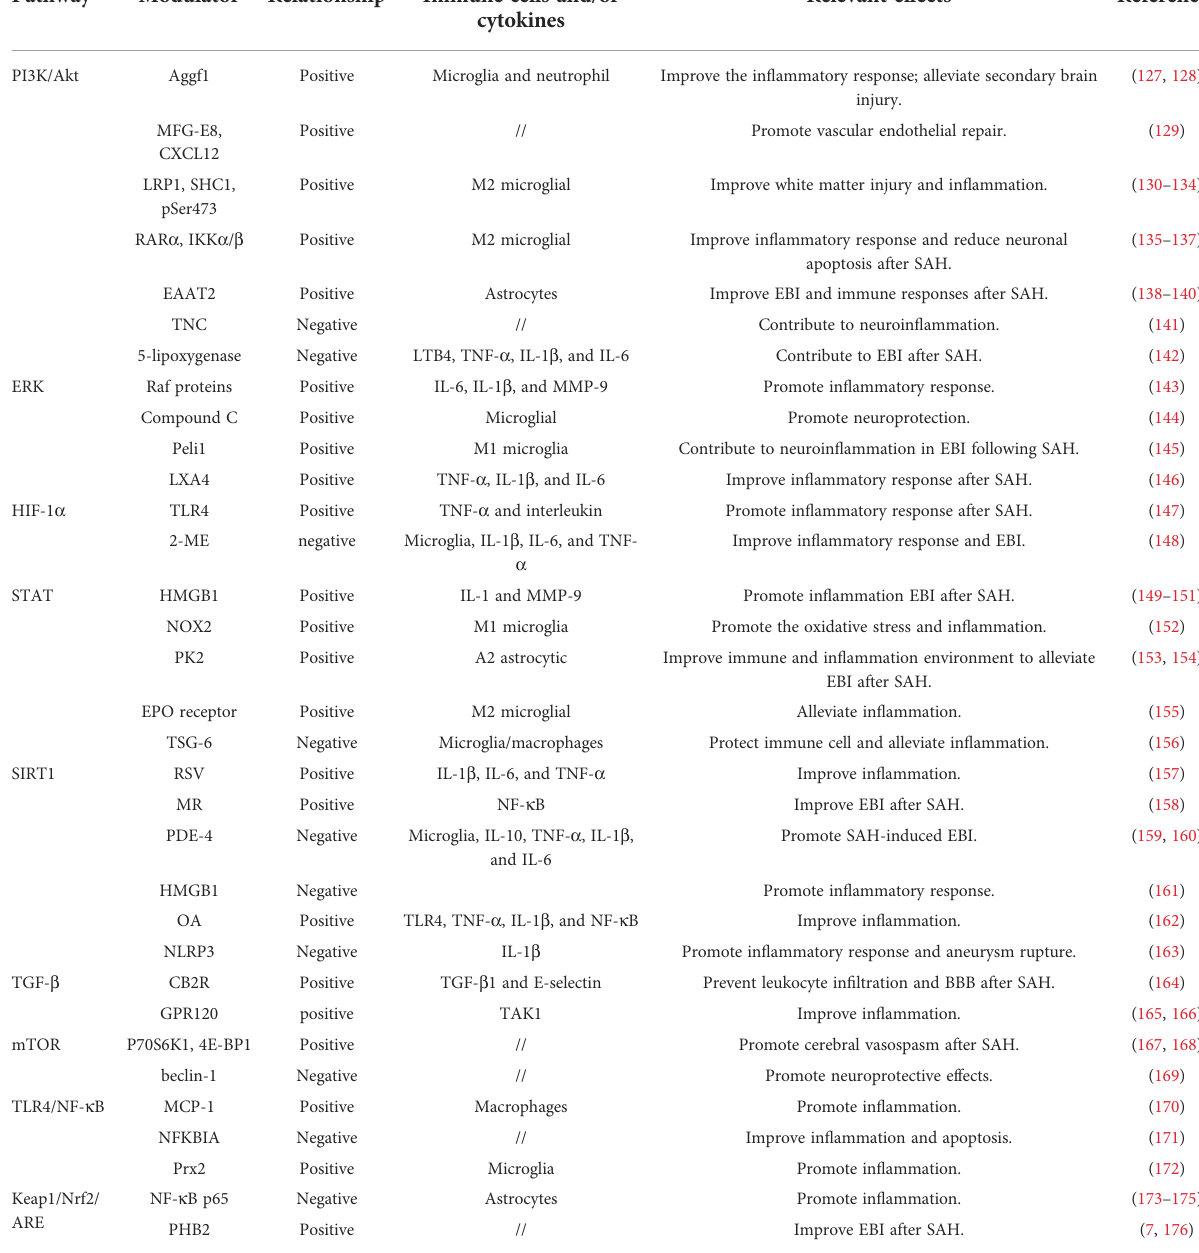
TABLE 1 Different pathways relevant modulators and effects in aneurysm